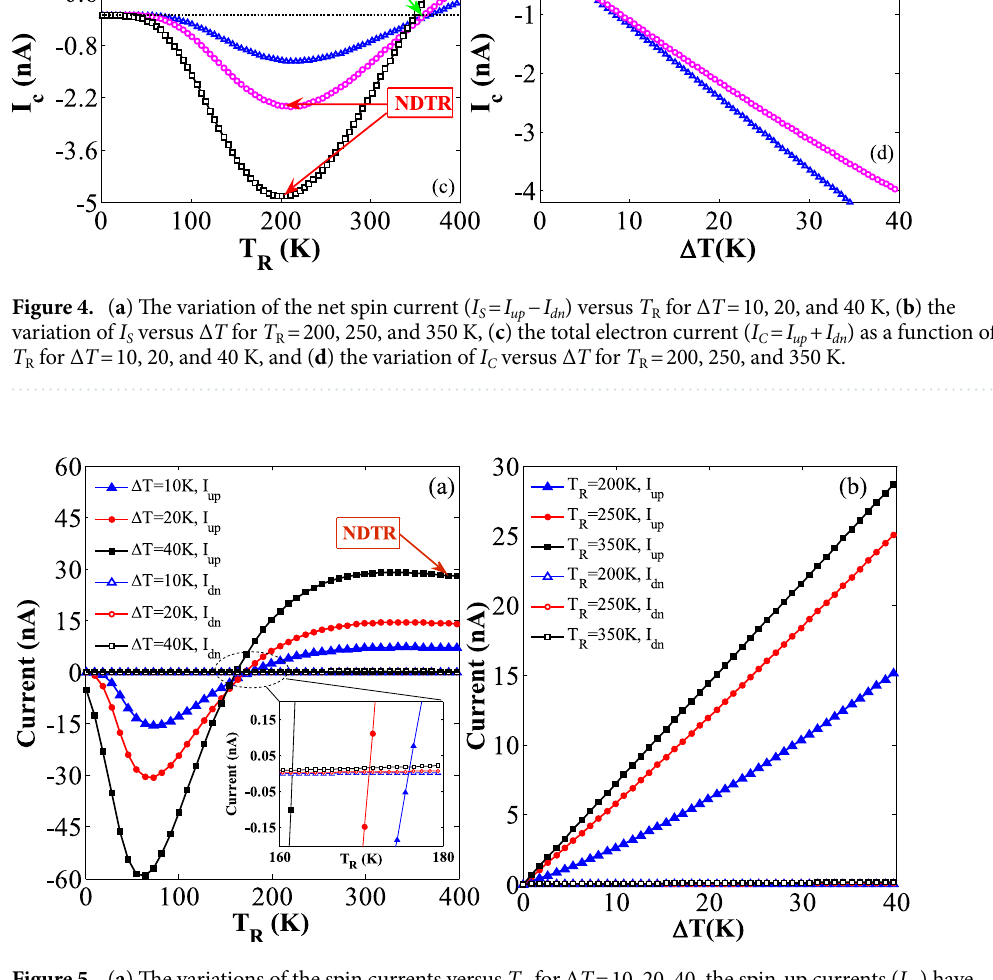
Figure 5. ( a ) The variations of the spin currents versus T R for ∆ T = 10, 20, 40, the spin-up currents ( I up ) have finite values and the spin-down currents ( I dn ) are nearly zero (i.e., SFE), and ( b ) the spin currents versus ∆ T for T R = 200, 250, and 350